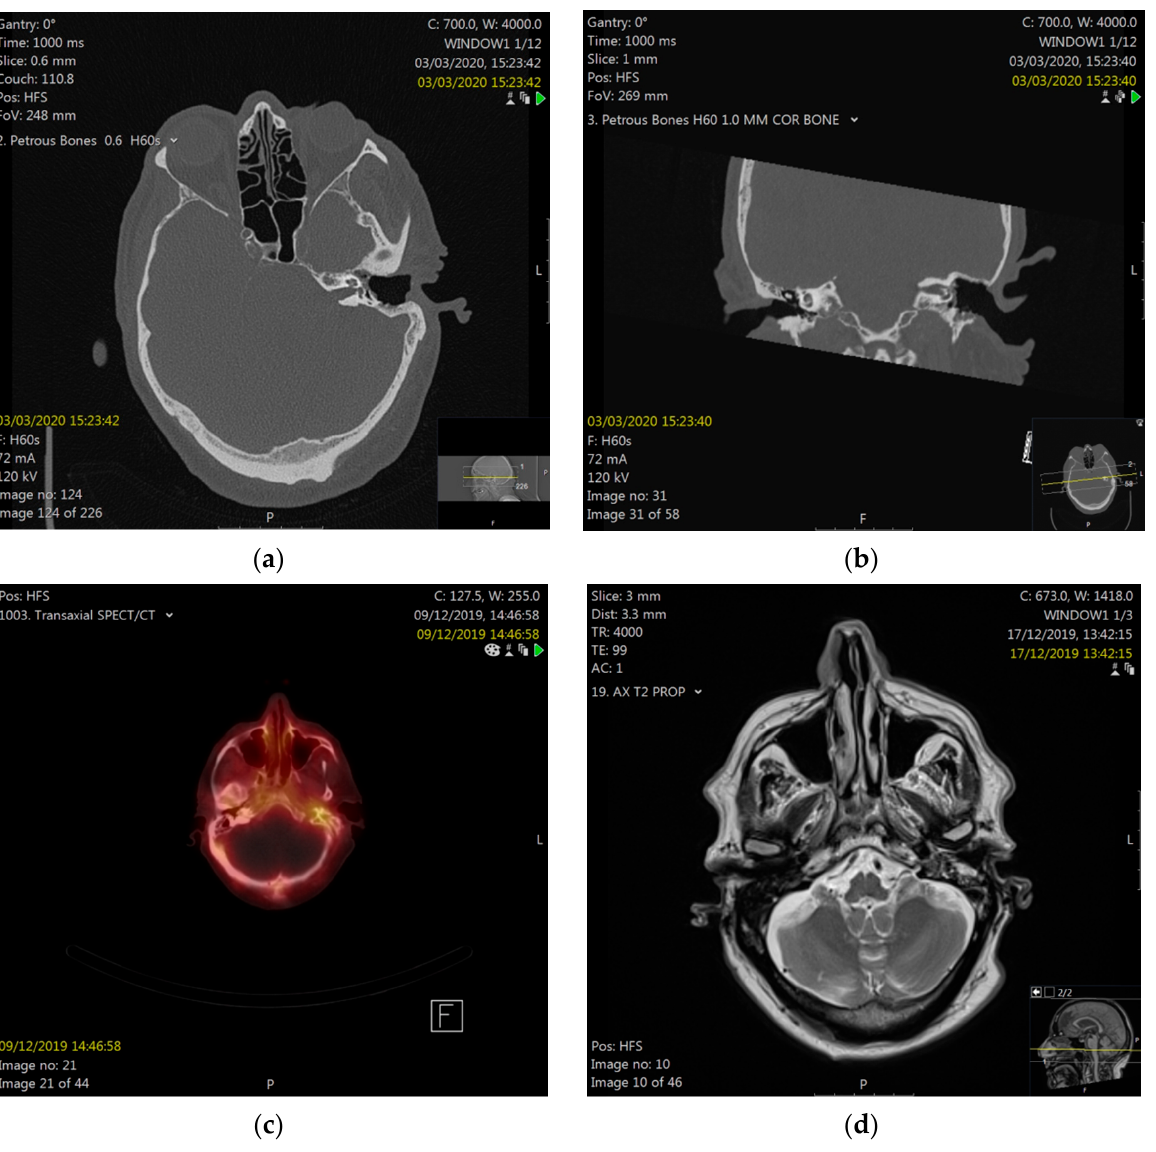
Figure 3. Computed tomography (CT) of petrous bones in axial ( a ) and coronal ( b ) planes, showing a situation after the left canal wall-down mastoidectomy, with patchy bony erosion of the floor of the external auditory meatus (white arrow) and uncovered facial nerve. Nuclear medicine scan ( c ) showing uptake around the left EAM. Magnetic resonance imaging (MRI) showing enhancement of the left mastoid ( d ).